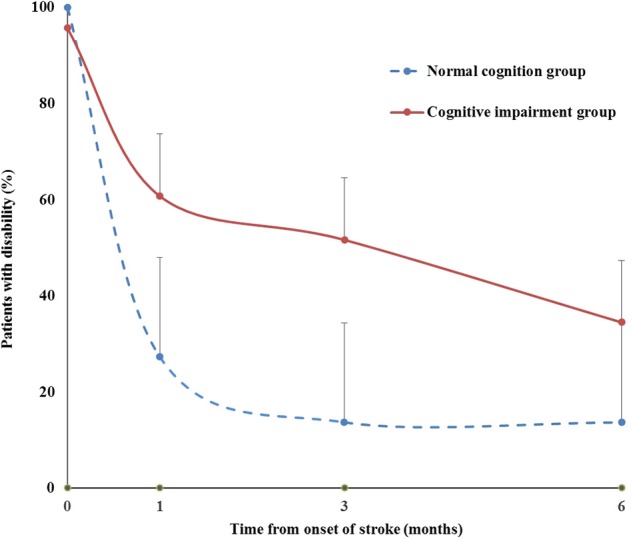
Time course of disability by baseline cognitive function.